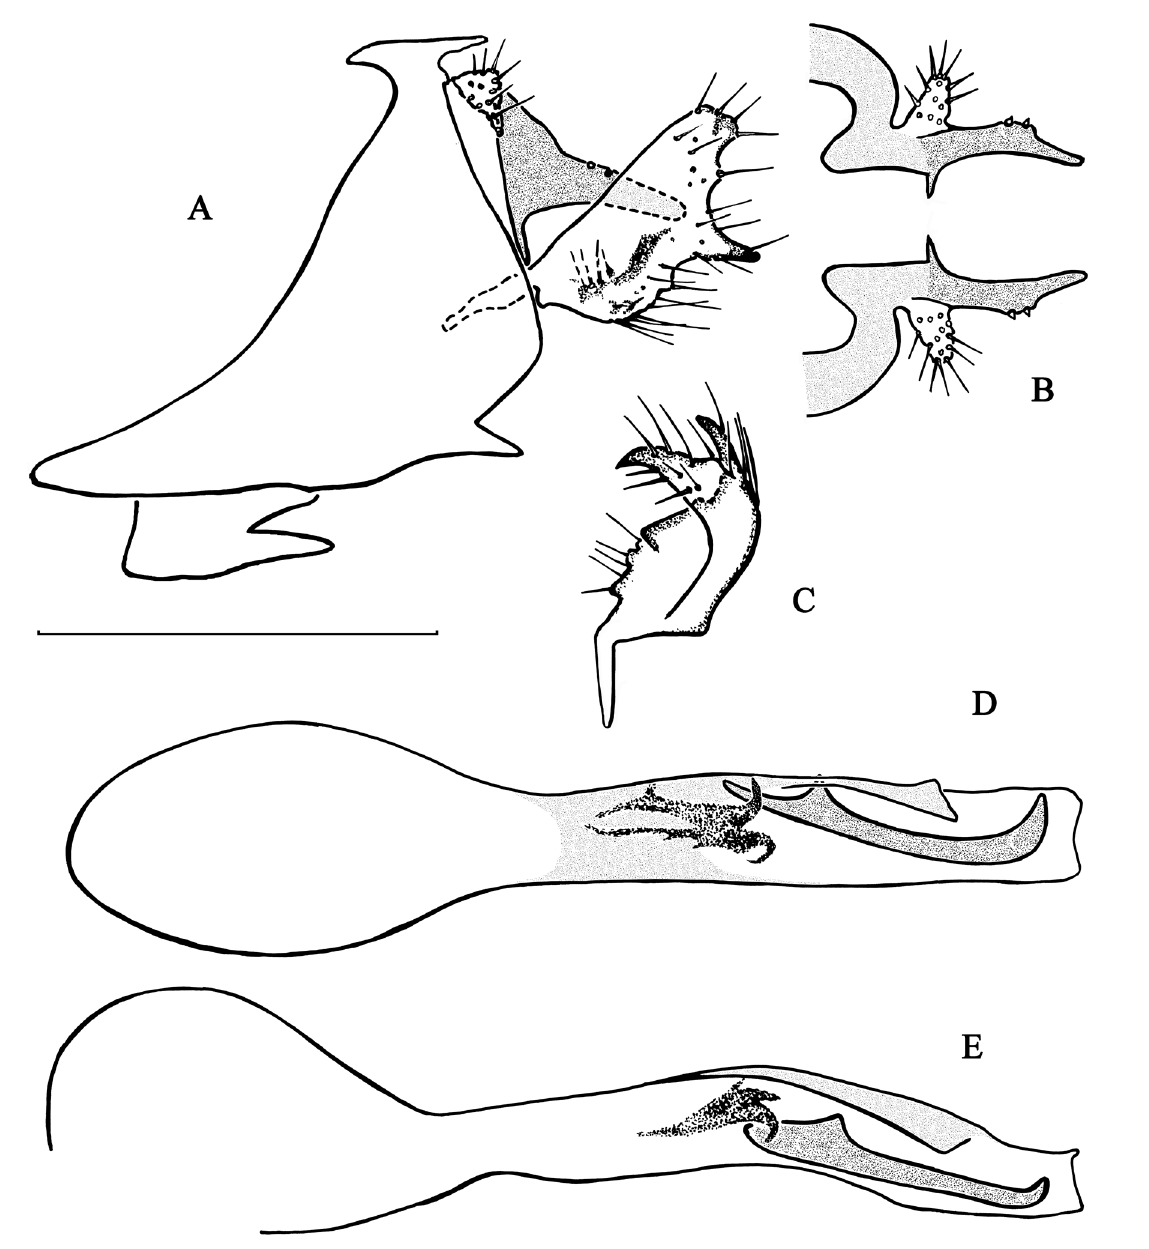
Fig. 10. Chimarra hamatra sp. nov. A–B . Abdominal segments IX and X. A . Lateral view with ventral margin of sternite VIII. B . Dorsal view. C . Inferior appendage, dorsal view. D–E . Phallic apparatus. D . Dorsal view. E . Lateral view. Scale bar =